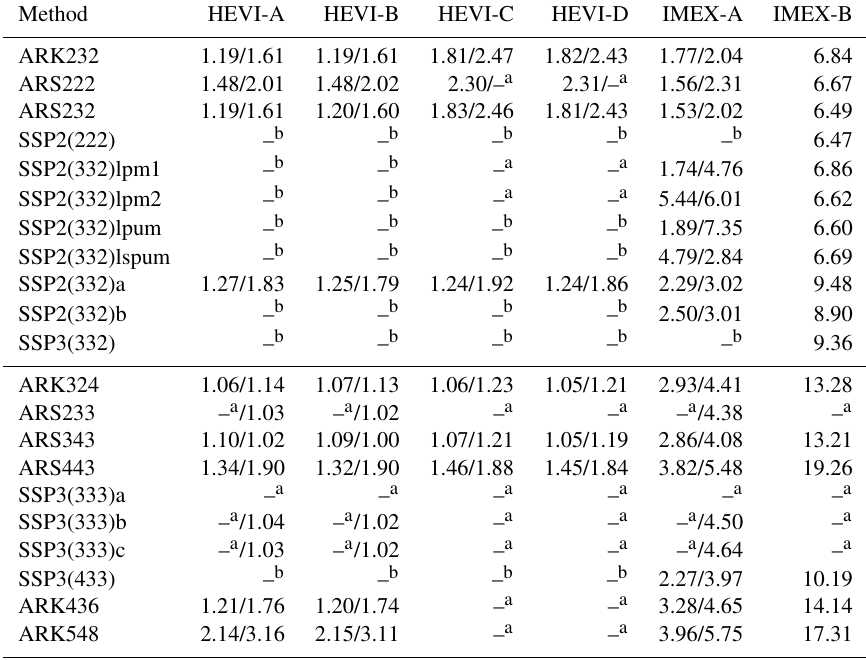
Table 3. The corresponding run times for the approximate largest acceptable step sizes in Table 2. Second-order methods are shown in the top section of the table and higher-order methods in the bottom section. The times have been normalized by the fastest simulation time, HEVI-B using ARS343 with the Newton solver (1372.483s). The value on the left of the “ / ” divider is the time for the Rosenbrock-like approach and the value on the right is the time for the Newton